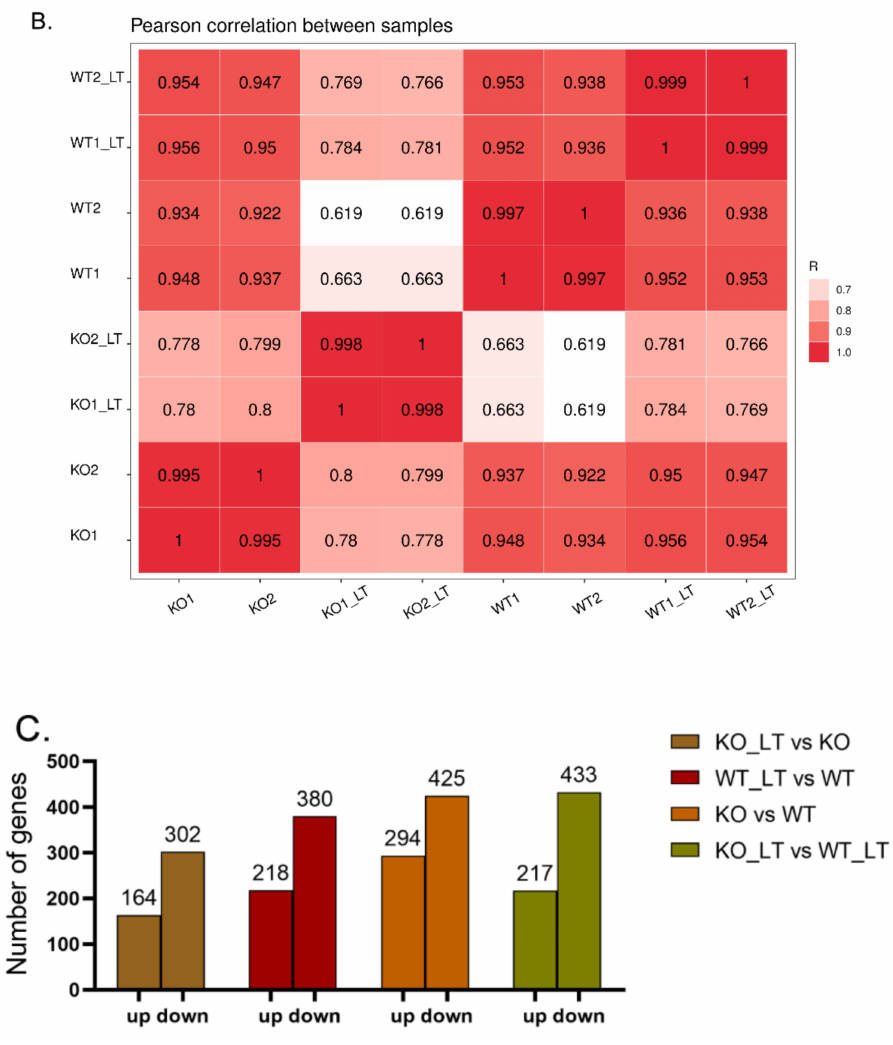
Figure 4. Experimental design, correction of sequencing samples, and number of DEGs in different comparisons. ( A ) Four treatments. ( B ) Person correlation of sequencing samples. ( C ) Up-regulated and down-regulated DEGs in four